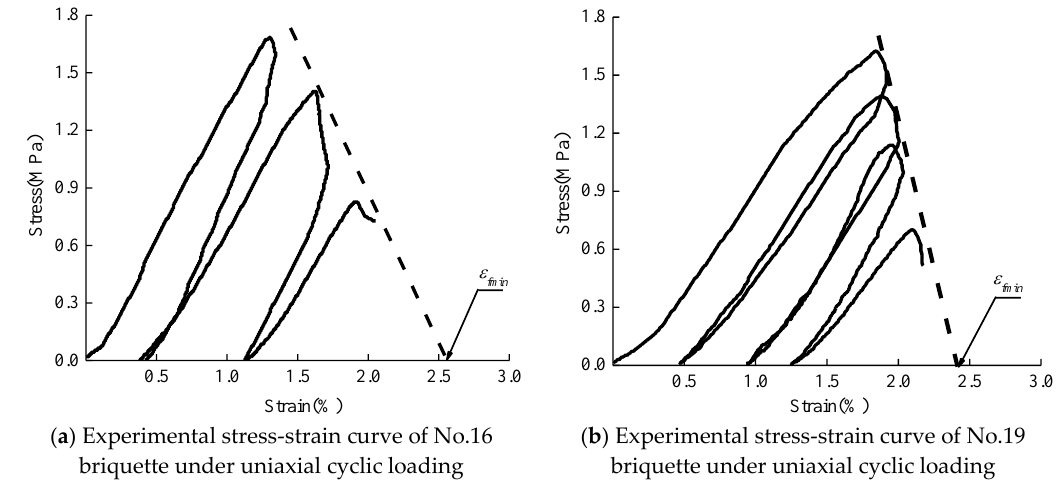
Figure 7. The acquisition method for parameter ε f min .